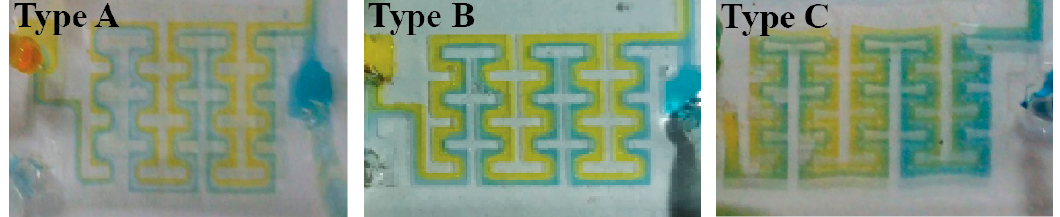
Figure 7. Differences of mixing efficiency along with various micro-channel structures.